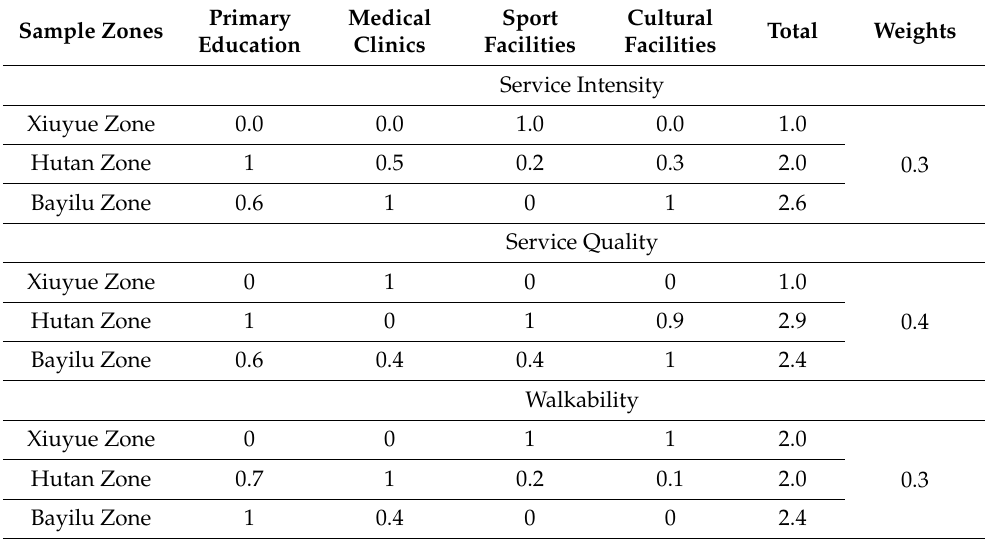
Table 1. Data normalization of public service facilities. Source: Authors.